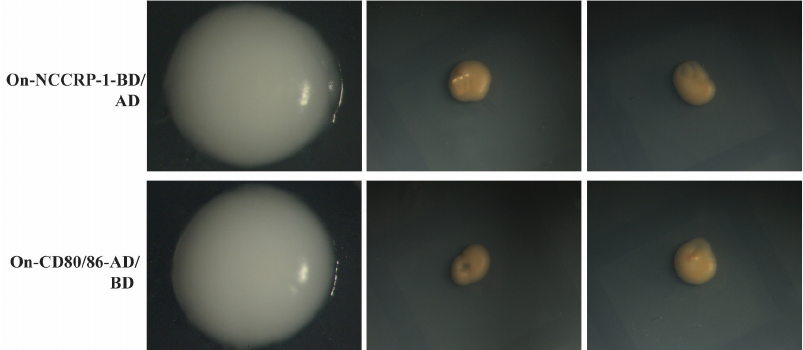
Figure 5. Interaction between On-NCCRP-1 and On-CD80/86 by Y2H. pGBKT7-On-NCCRP-1/pGADT7-On-CD80/86 is the experimental group; pGBKT7-Lam/pGADT7-T is the negative control group; pGBKT7-53/pGADT7-T is the positive control group; and pGBKT7-On-NCCRP-1/pGADT7 and pGADT7-On-CD80/86+pGBKT7 are the self-activation groups. Column ( A – C ): Yeasts grown on plates with double dropout medium (SD/–Leu/–Trp), quadruple dropout medium (SD/-Leu/-Trp/-His/-Ade), and quadruple dropout medium supplemented with X-a-Gal (SD/-Leu/-Trp/-His/-Ade/X-a-Gal), respectively.